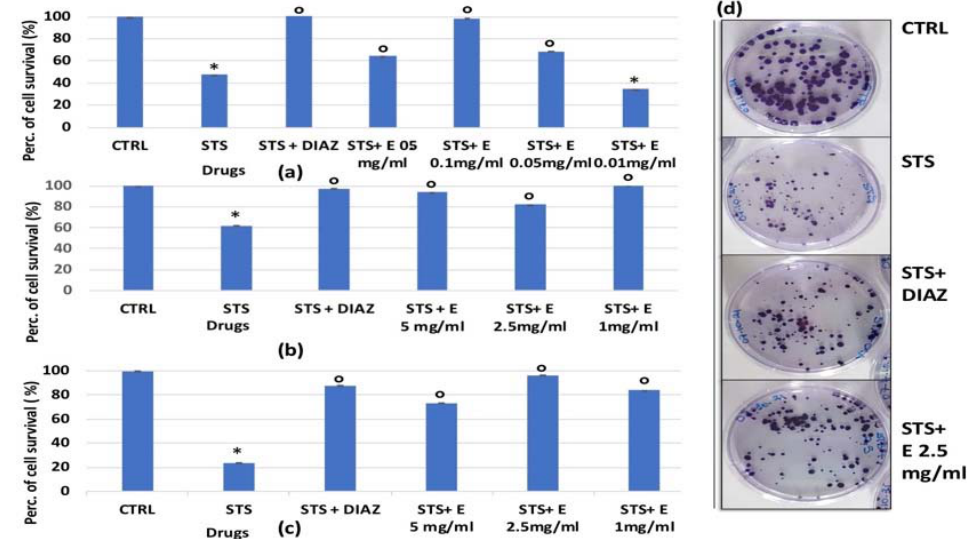
Figure 6. Percentage of cell growth values for HEK293 cells co ‐ incubated with staurosporine 2.14 × 10 − 6 M (STS) and diazoxide 250 × 10 − 6 M (DIAZ) or various concentrations of the extract (E) measured with crystal violet assay vs. controls (CTRL). Panels: ( a ) show data at lowest concentrations of the extract (0.5 mg/mL, 0.1 mg/mL, 0.05 mg/mL and 0.01 mg/mL) after 6 h of incubation. Panels: ( b , c ) show data at highest extract concentrations (5 mg/mL, 2.5 mg/mL, and 1 mg/mL) after 3 and 6 h of incubation, respectively. The reported values represent an average of at least seven replicates. ( d ) The effect of STS 2.14 × 10 − 6 M, diazoxide 250 × 10 − 6 M, and extract (2.5 mg/mL) on cell clone for ‐ mation was evaluated after 3 h of incubation measured in the clonogenic assay. One ‐ way analysis of variance with ANOVA was performed to determine the significance of the data vs. controls * or cytototoxic ° compounds with a value of p < 0.05.